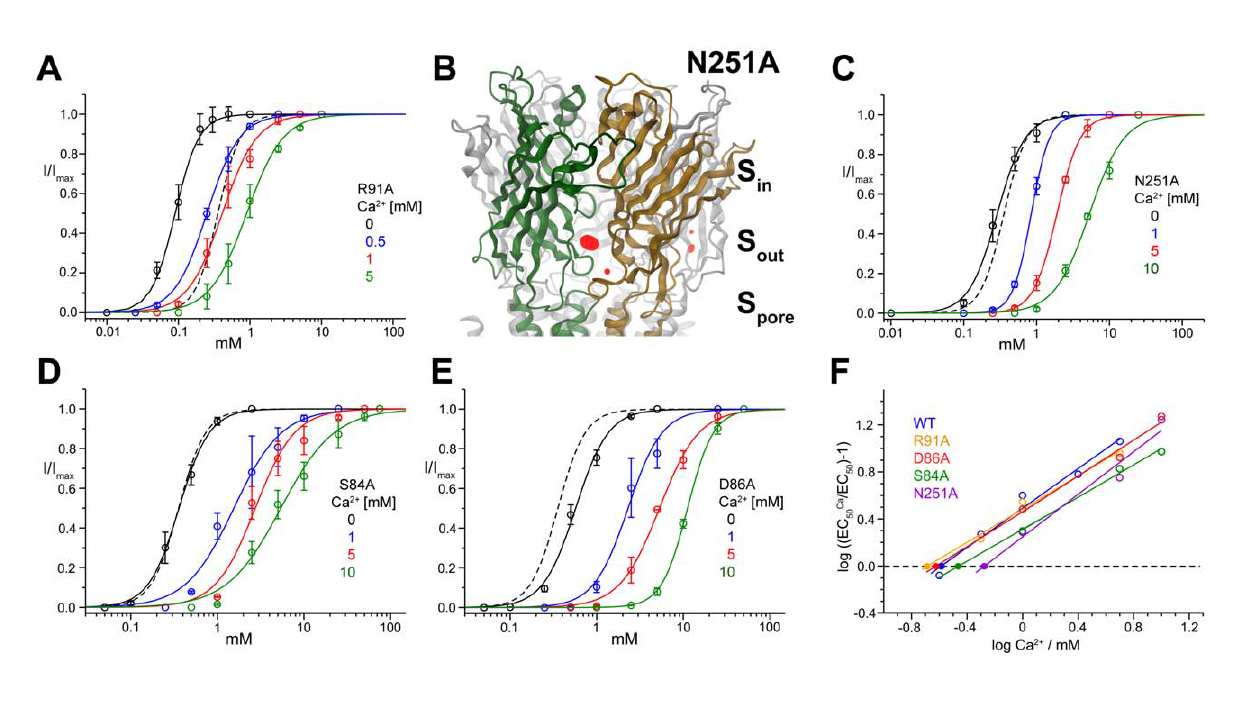
Figure 4. Divalent ion inhibition in mutants of the nonregulatory sites S pore and S in . Dose–response relationships of the ELIC point mutant R91A (A) activated by cysteamine at different concentrations of Ca 2 + . (B) Anomalous difference electron density (calculated at 5 A˚ and contoured at 5 s ) from data of the mutant N251A in complex with Ba 2 + superimposed on a model of ELIC in ribbon representation. Ion-binding sites are indicated. Dose–response relationships of the ELIC point mutants N251A (C), S84A (D), and D86A (E) activated by cysteamine at different concentrations of Ca 2 + . The data presented in panels (A), (B), (D), and (E) are averages from at least 5 oocytes; errors are SD. The solid lines show fits to a Hill equation. Currents were recorded at 2 40 mV. A dose–response curve of WT in the absence of Ca 2 + (dashed line) is shown for comparison. (F) Schild plots N quantifying the inhibition of ELIC mutants by Ca 2 + . EC 50 values were obtained from fits to data shown in panels (A), (B), (D), and (E). Potencies of the ). WT is shown for antagonists (pA values) were obtained by linear regression; the intersection with the x -axis is indicated (